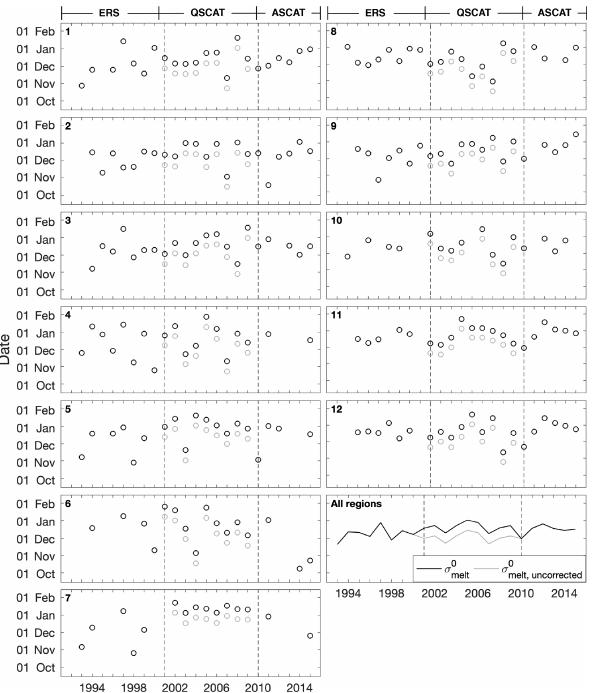
Figure 7. Time series of snowmelt onset dates in the perennial sea- ice zone for individual regions 1–12 (Fig. 1) and all regions av- eraged (bottom right, upper panel). Grey circles (and grey line in bottom right) show the uncorrected QSCAT melt onset dates, while black symbols show dates corrected by 11d, the difference between Ku- and C-band melt onset dates, respectively.